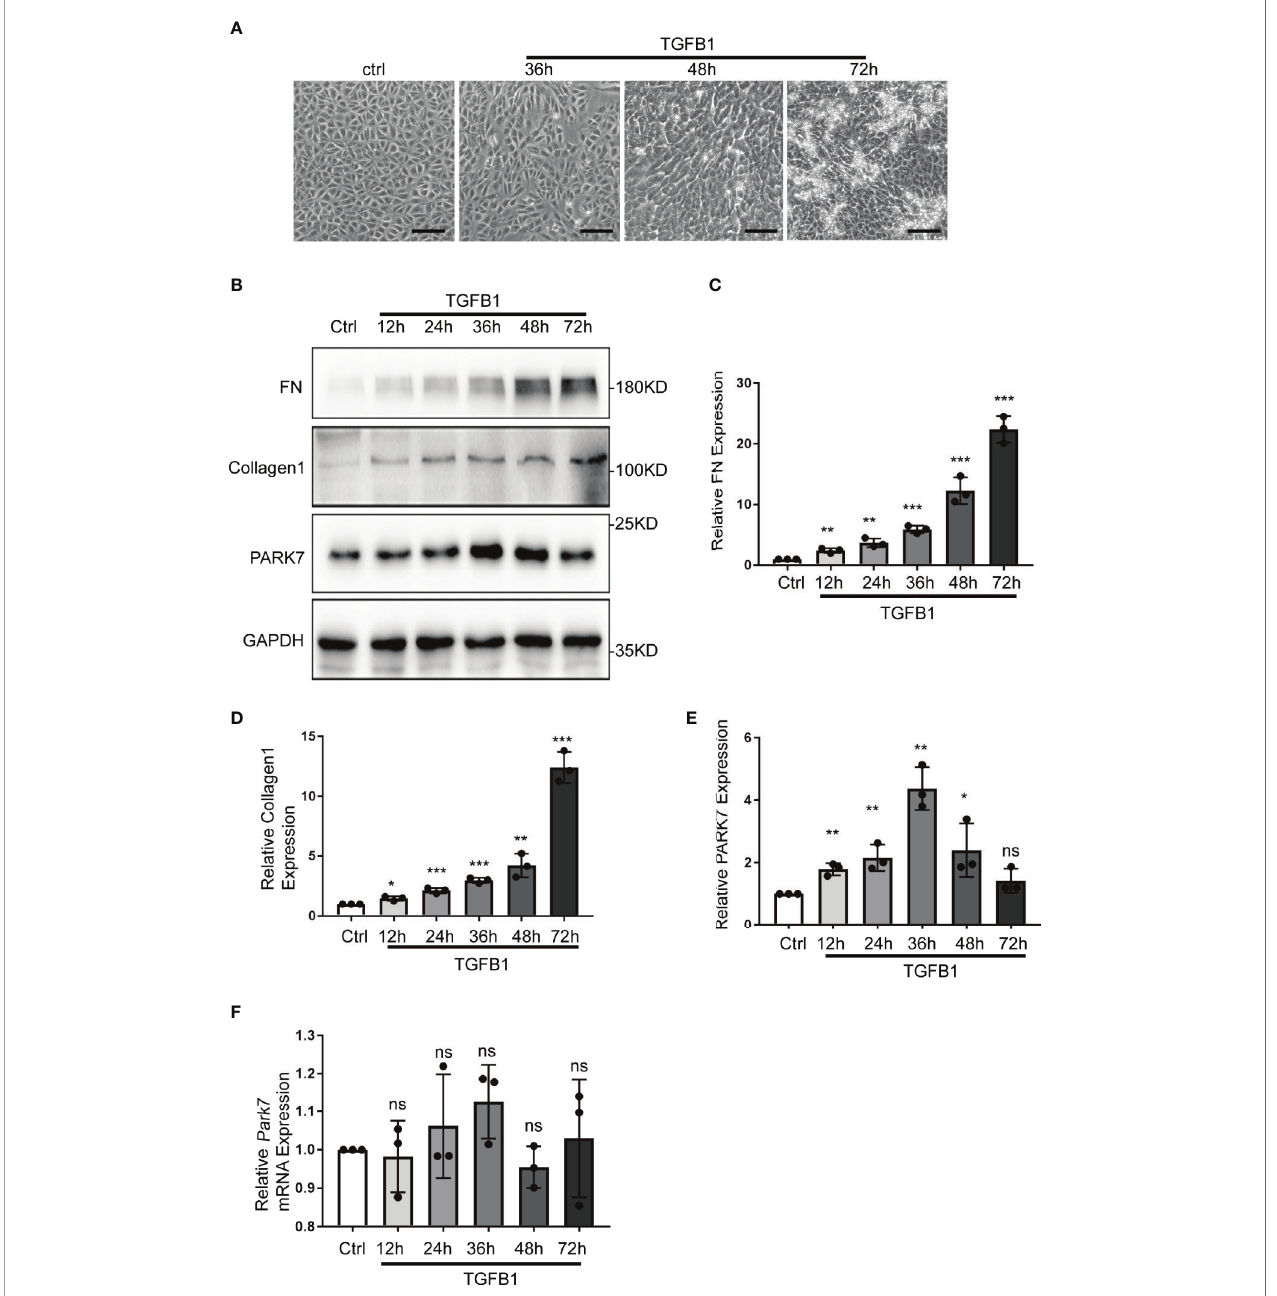
FIGURE 5 | TGFB1 treatment altered PARK7 expression in BUMPT cells. BUMPT cells were incubated with 5 ng/ml TGFB1 for 12h to 72h, and the cells treated without TGFB1 were as control (Ctrl). (A) Representative images of contrast microscopy to show cellular morphologic changes. Bar:100 m m. (B) Representative immunoblot of Fibronectin (FN), Collagen 1, PARK7 and GAPDH (protein loading control) in whole cell lysates. (C – E) Densitometry of FN, Collagen 1 and PARK7 (n=3). The signal of FN, Collagen 1, or PARK7 was normalized to the GAPDH signal of the same samples to determine the ratios. The values are expressed as fold change over control cells. Each symbol (circle) represents an independent experiment. (F) Quanti fi cation of Park7 mRNA levels. Error bars: SEM. *p < 0.05, **p < 0.01, ***p < 0.001. ns, not signi fi